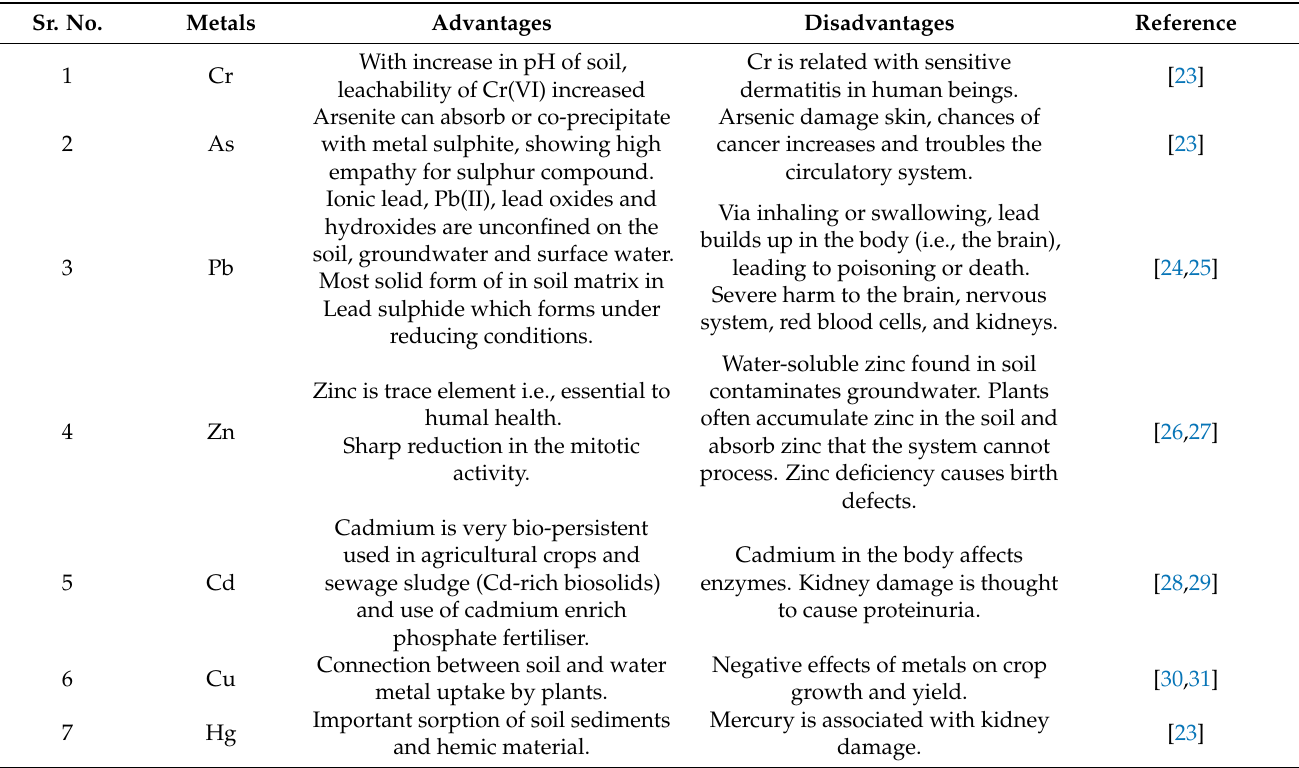
Table 1. Advantages and disadvantages of the heavy metals found in soil. Sr.